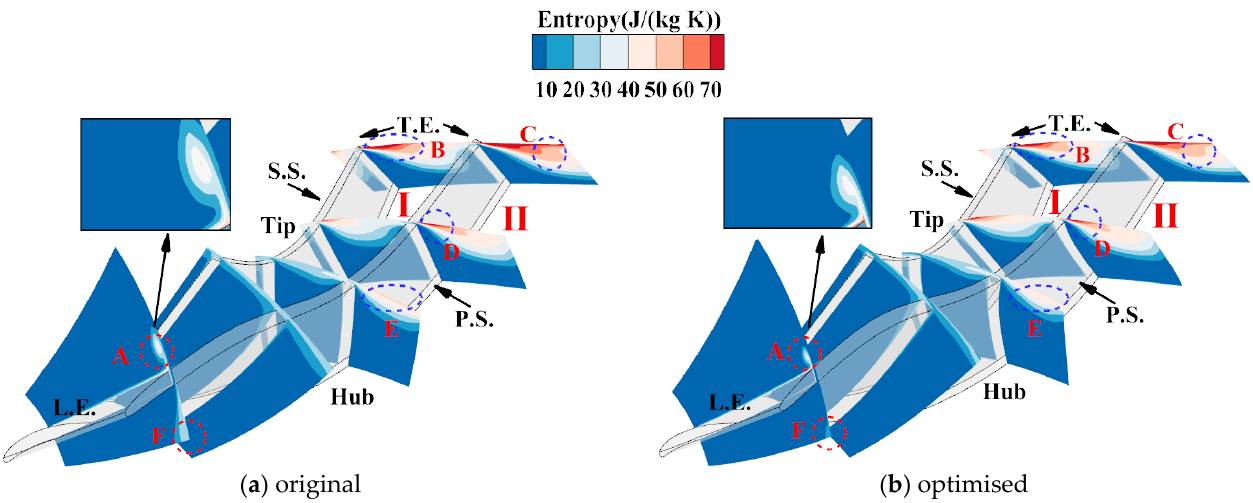
Figure 14. Entropy contour of the S3 cross ‐ section before and after optimisation (common operating condi ‐ tion).